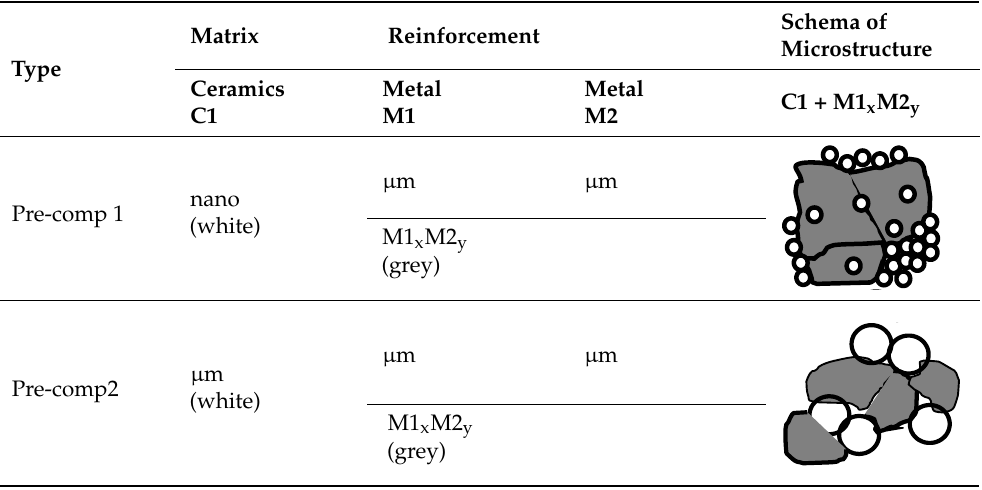
Table 3. Types of microstructures of pre-composite powders fabricated by consolidation of powders, one ceramic and two metals, with various variants of ceramics and metal powder size and their geometrical schemas.